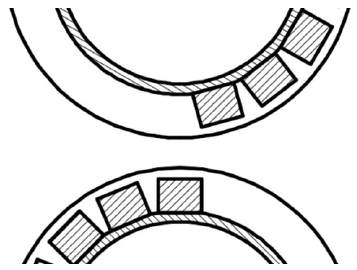
Figure 4. Separator magnets interaction